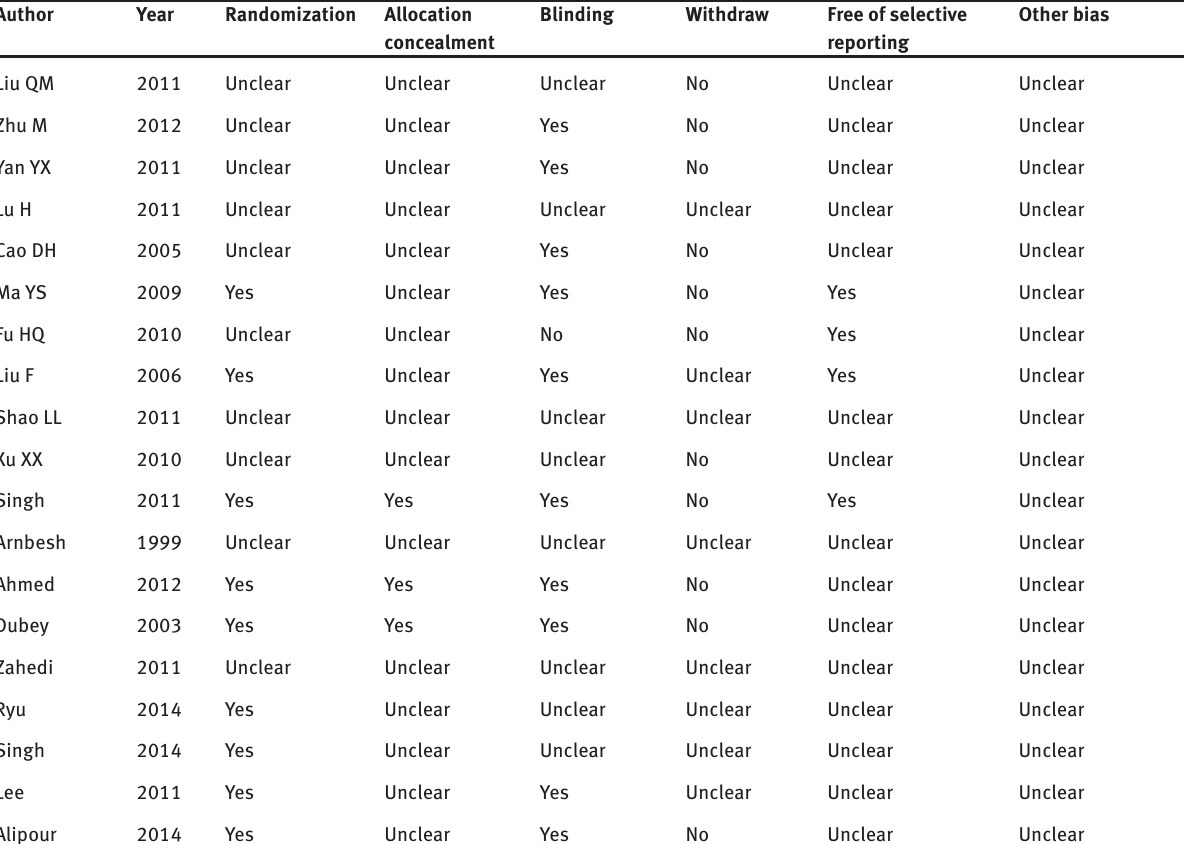
Table 2: The general quality of the included 19